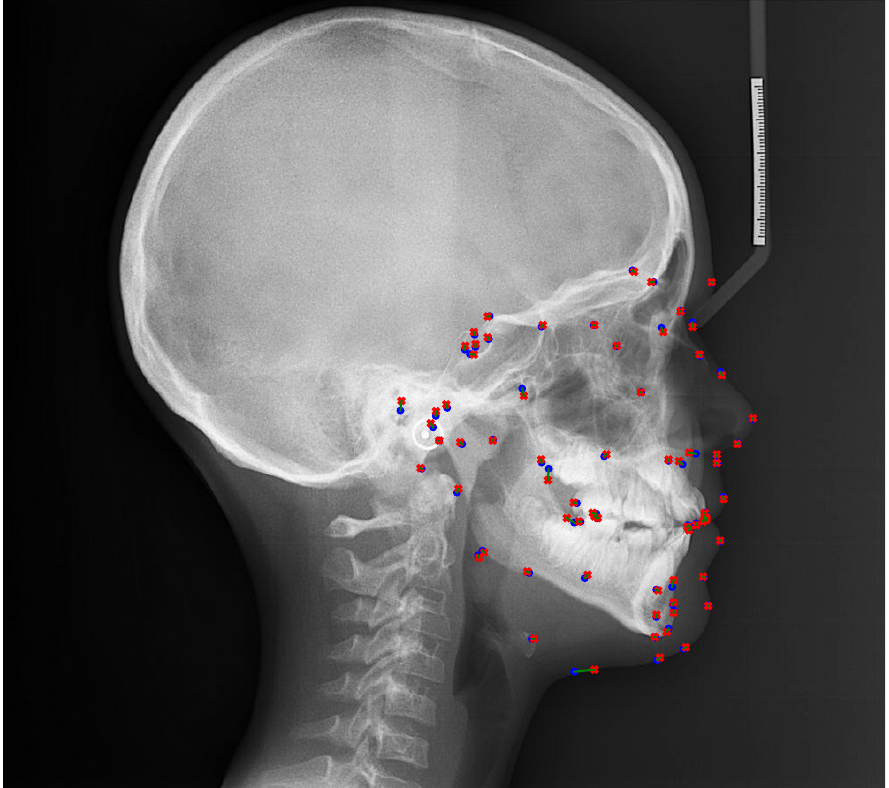
Figure 4. Sample detection result, superimposed on the X-ray image from the AUDAX private database. Cephalometric landmarks were determined by the proposed SCN-EXT method. Estimated landmarks are denoted by a red x, while ground-truth locations are superimposed as blue